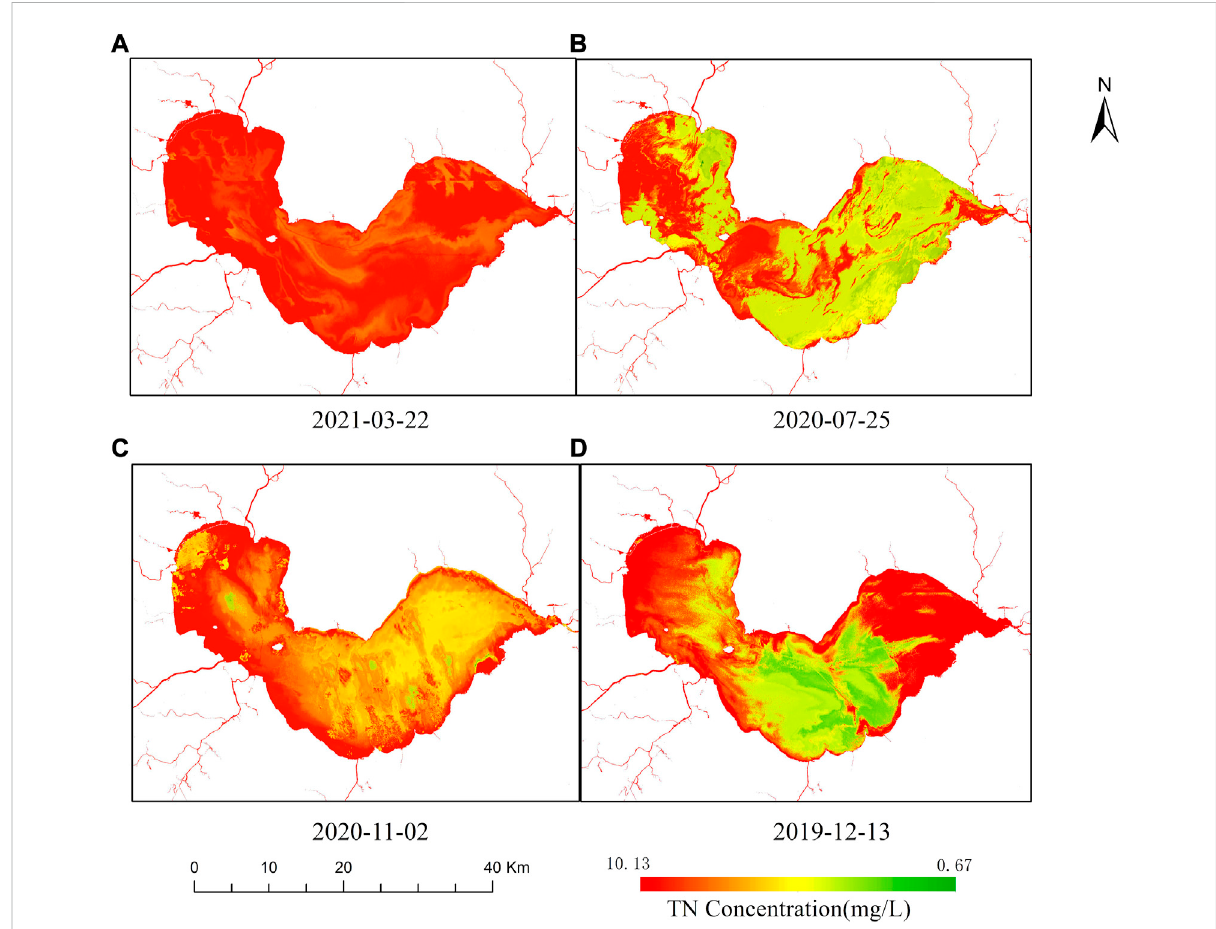
FIGURE 5 Remote-sensing retrieval results of the TN concentrations in the water around Chaohu Lake. (A) Total nitrogen distribution on March 22, 2021 (B) Total nitrogen distribution on July 25, 2020 (C) Total nitrogen distribution on November 2, 2020 (D) Total nitrogen distribution on December 13,